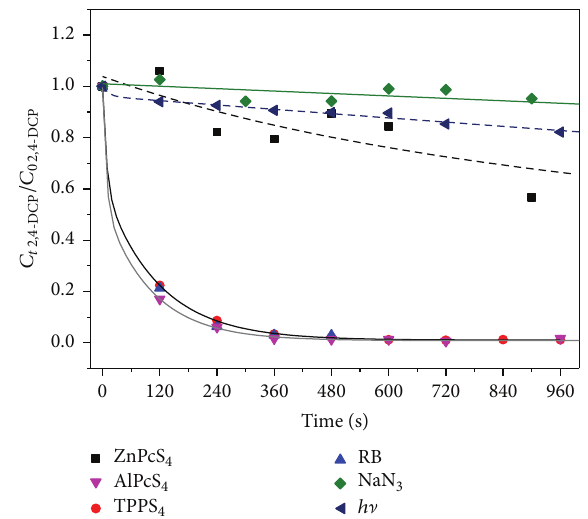
Figure 5: The dependence of 2,4-DCP relative concentrations decay on the type of used photosensitizer, in the absence of any sensitizer and in the presence of singlet oxygen scavenger, sodium azide = 2.4 × 10 −4 M, 𝐶 0 sens . = 2 × 10 −5 M, 𝐶 0 NaN ( 𝐶 02,4 - DCP pH = 10.8, air bubbling, and natural sunlight irradiation).